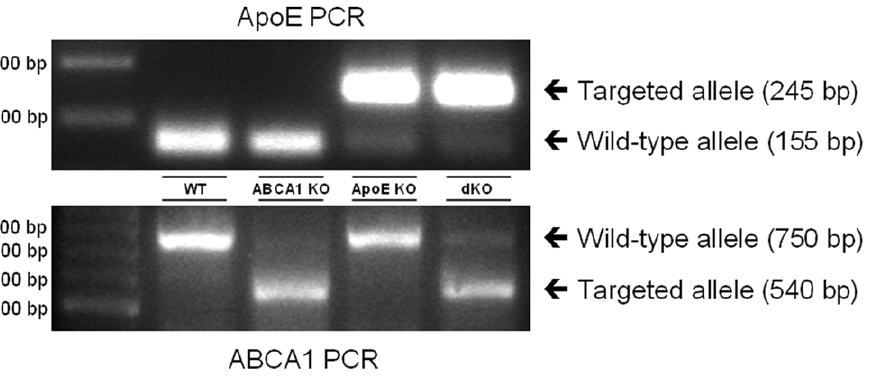
Figure 1. Successful disruption of macrophage ABCA1 and apoE by bone marrow transplantation. RT-PCR on genomic DNA of bone marrow isolated from ABCA1 and/or apoE KO transplanted LDLr KO mice and their WT transplanted controls at 17 weeks after